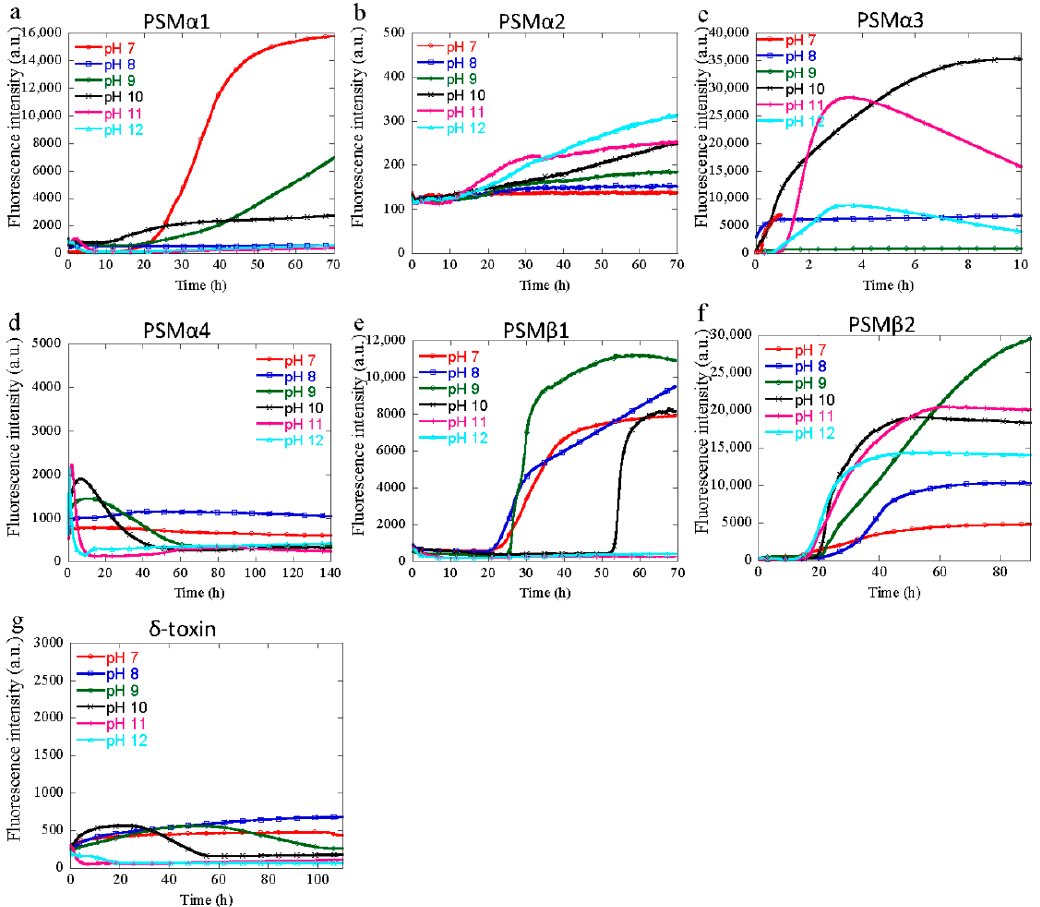
Figure 2. Experimental kinetics of PSM aggregation at 37 ◦ C every 10 min under quiescent conditions for single monomeric concentration at basic and neutral (pH 7–12) solution conditions. Three repeats were carried out at each conditions. ( a ) Aggregation kinetics of PSM α 1. ( b ) Aggregation kinetics of PSM α 2 (0.25 mg/mL). ( c ) Aggregation kinetics of PSM α 3 (0.5 mg/mL). ( d ) Aggregation kinetics of PSM α 4 (0.25 mg/mL). ( e ) Aggregation kinetics of PSM β 1 (0.25 mg/mL). ( f ) Aggregation kinetics of PSM β 2 (0.25 mg/mL). ( g ) Aggregation kinetics of δ -toxin (0.3 mg/mL).